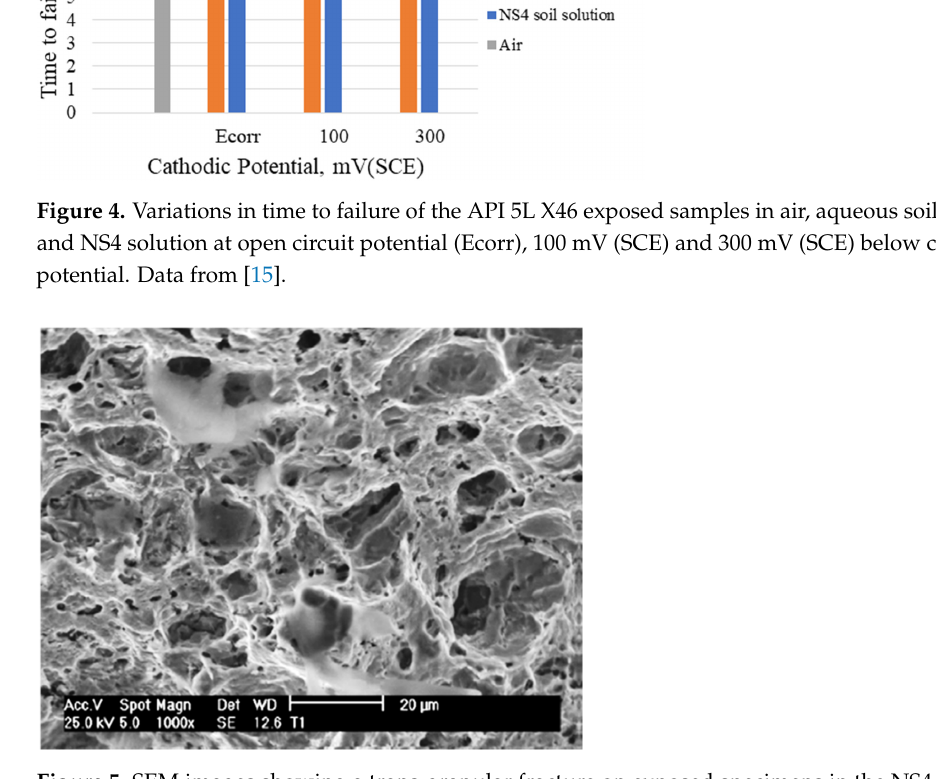
Figure 5. SEM images showing a trans-granular fracture on exposed specimens in the NS4 solu- tion with applied potential of − 400 mV (SCE) [50]. Reprinted with permission from [50], 2012, Else-